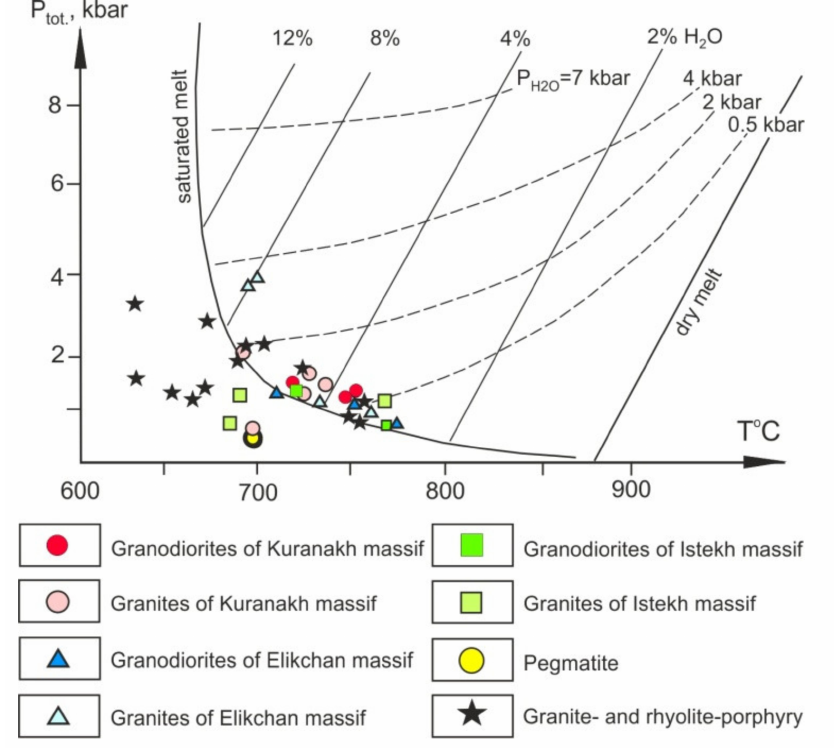
Figure 6. P–T-diagram of the granite-water system for independent P tot. and P H2O